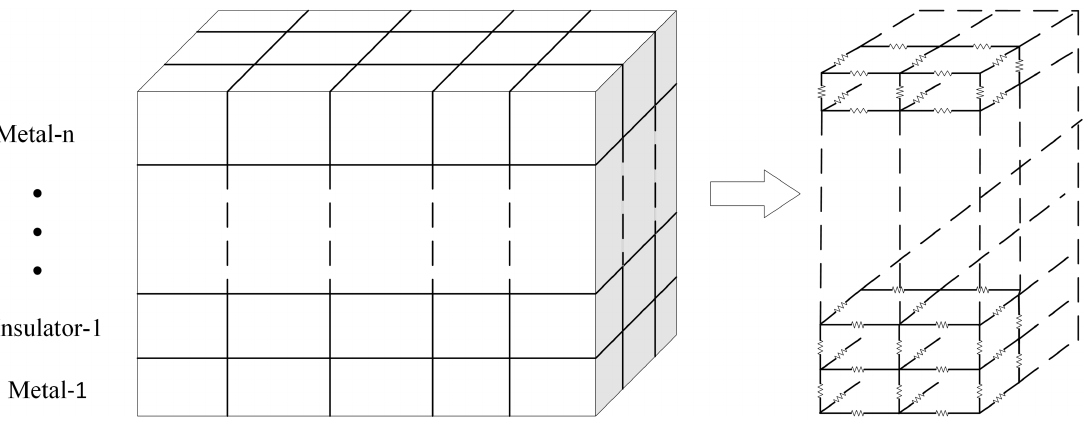
Figure 2. Example of a 3D thermal grid that is used for